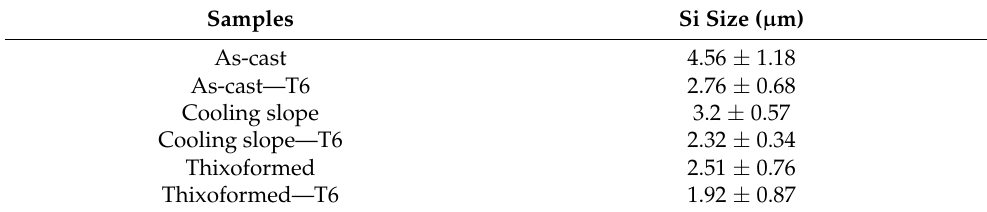
Table 1. Average size of Si particles.